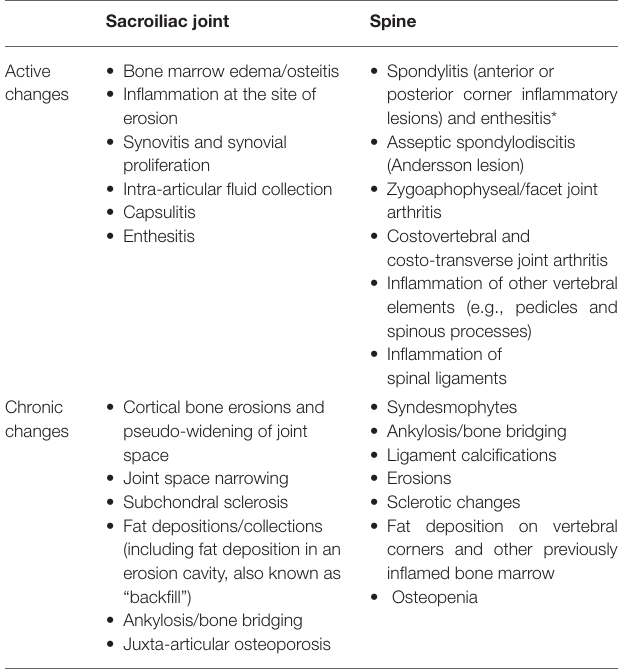
Sacroiliac joint